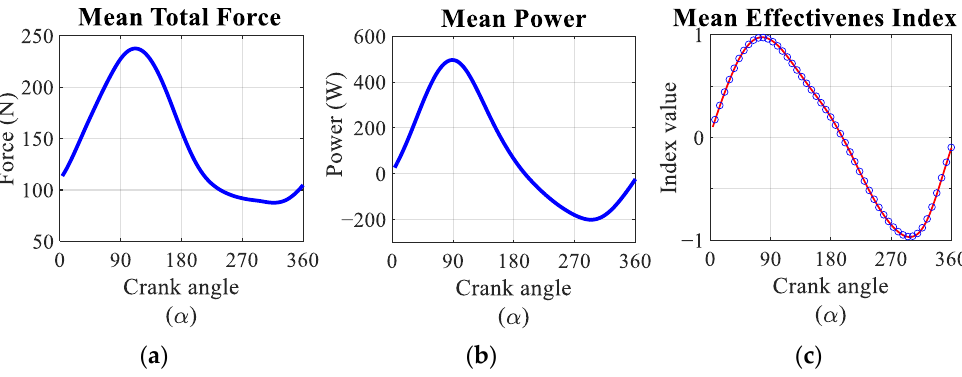
Figure 14. ( a ) Mean total force calculated as the result of F T and F R . ( b ) Mean effective power time evolution applied to the pedal. ( c ) Comparison between the average of EIE 2D and EIE 3D . Red dot and dash line: EIE 2D . Blue circles: EIE 3D .